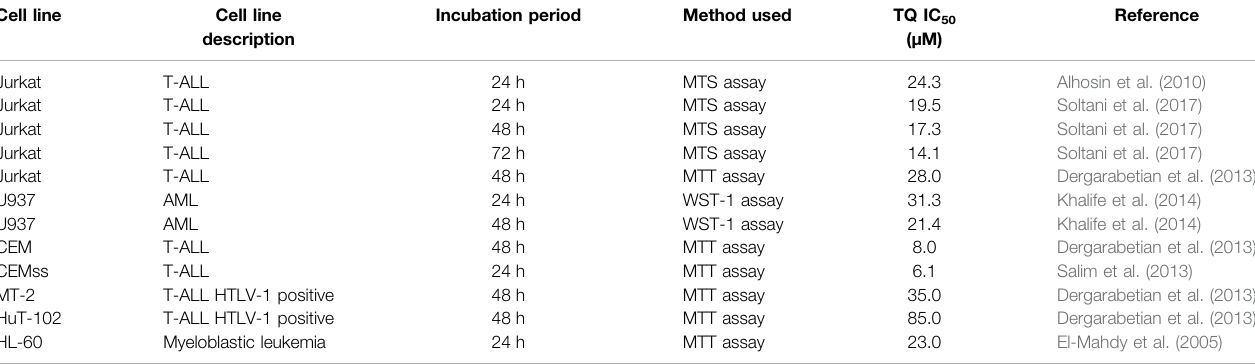
TABLE 4 | Half maximal inhibitory concentration (IC 50 ) values found in the literature for thymoquinone (TQ) in leukemia cell lines. Cell